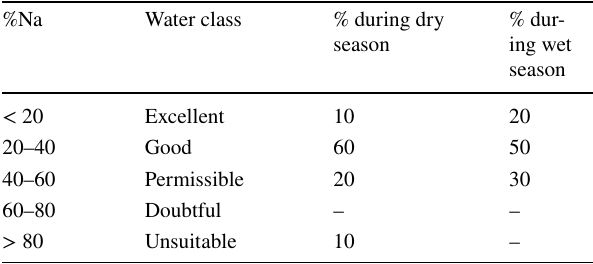
Table 10 Quality of groundwater based on %Na